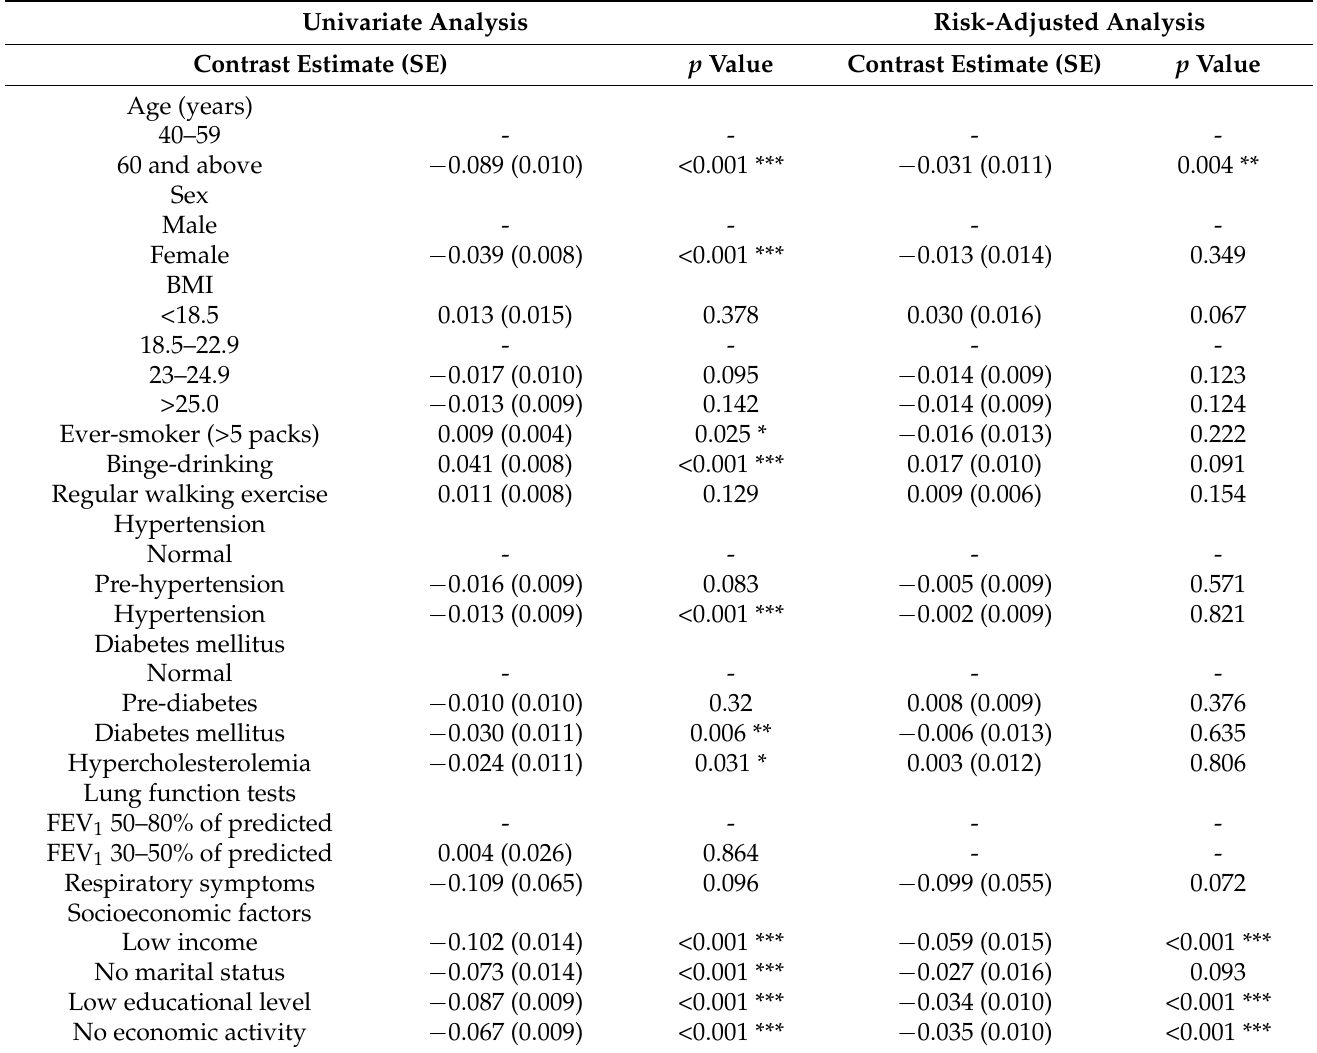
Table 2. Factors associated with health-related quality of life in the preserved ratio impaired spirometry (PRISm) group.